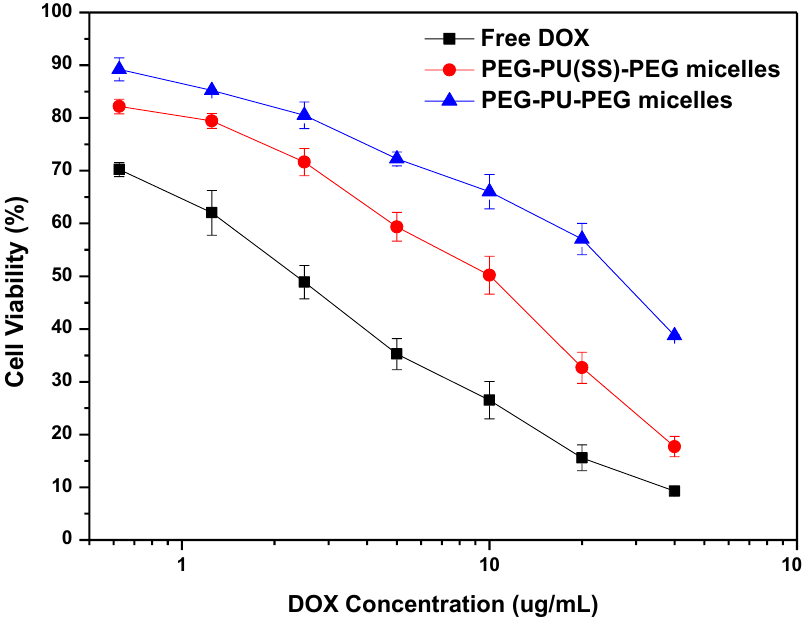
Figure 6. Anti-tumor activity of DOX-loaded PEG-PU(SS)-PEG micelles, DOX-loaded PEG-PU-PEG micelles, and free DOX as a function of DOX dosages. The cells (C6) were incubated with DOX-loaded micelles or free DOX for 48 h. Data are presented as the average ± standard deviation ( n = 6).